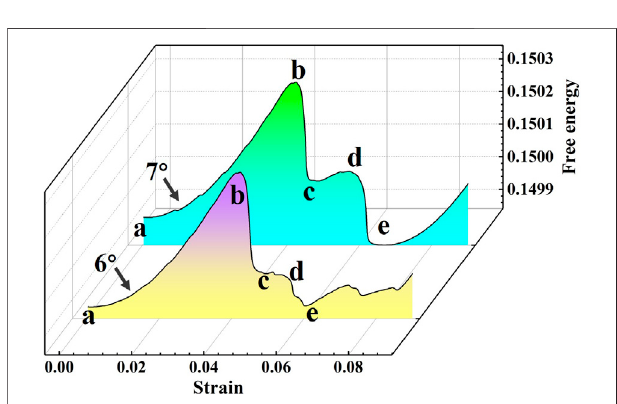
FIGURE 5 | The free energy curve of 6 ° and 7 ° grain boundary dislocation evolution process during the x -direction tensile deformation.